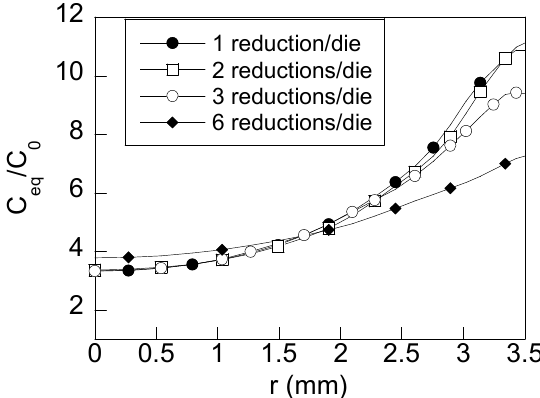
Figure 9. Time evolution of relative concentrations of hydrogen ( C / C 0 ) at two points placed at: ( a ) r / a = 0.90, ( b ) r / a = 0.50.